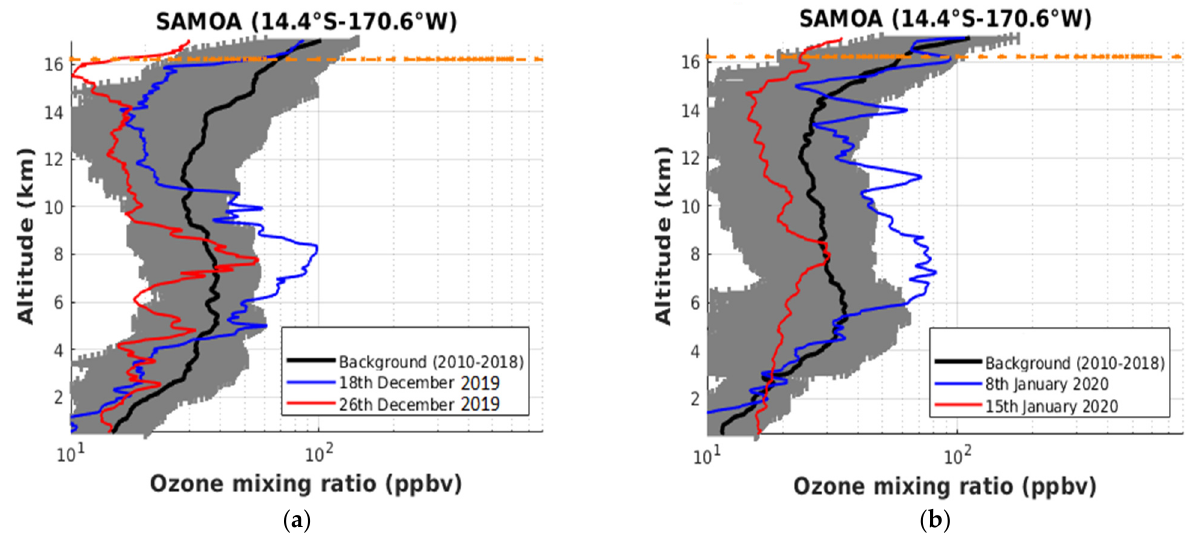
Figure 9. OMR profiles obtained from ozone radiosonde measurements performed at Samoa on ( a ) December 2019 and ( b ) January 2020. The monthly mean profile and the associated standard deviation calculated during the 2010–2018 period are in black lines and grey areas, respectively. The tropopause height is indicated by the orange horizontal lines.